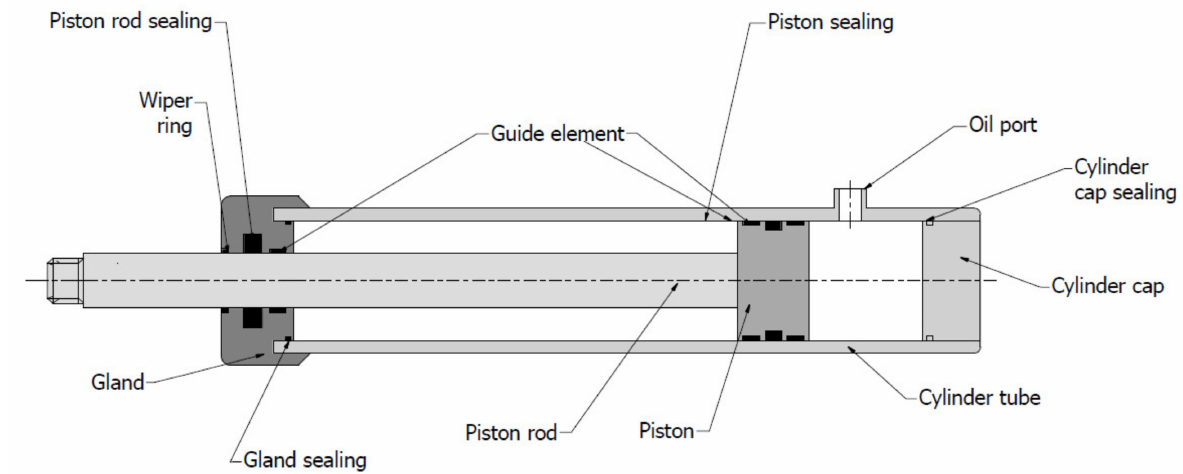
Figure 3. Design of hydraulic piston